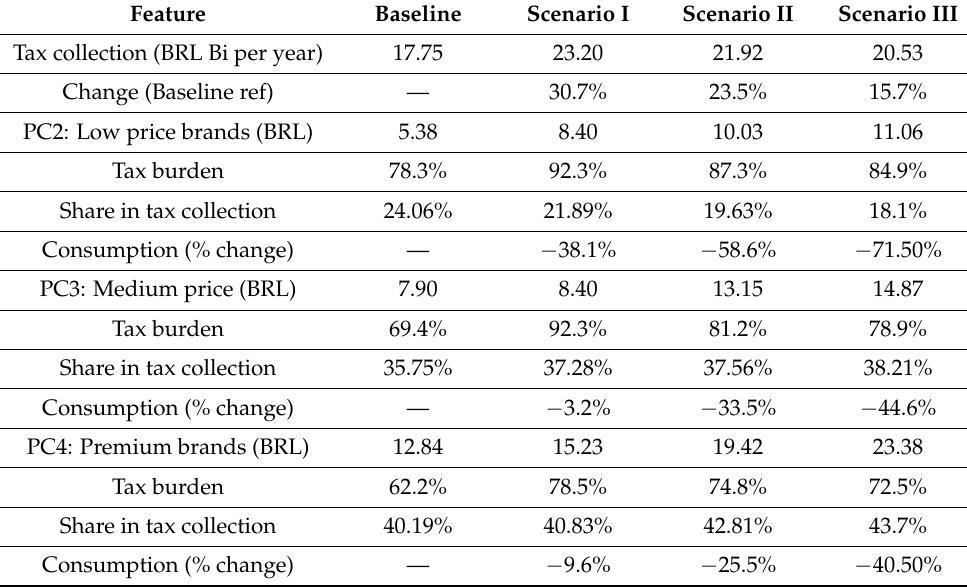
Table 2. Tax reform simulation results across different